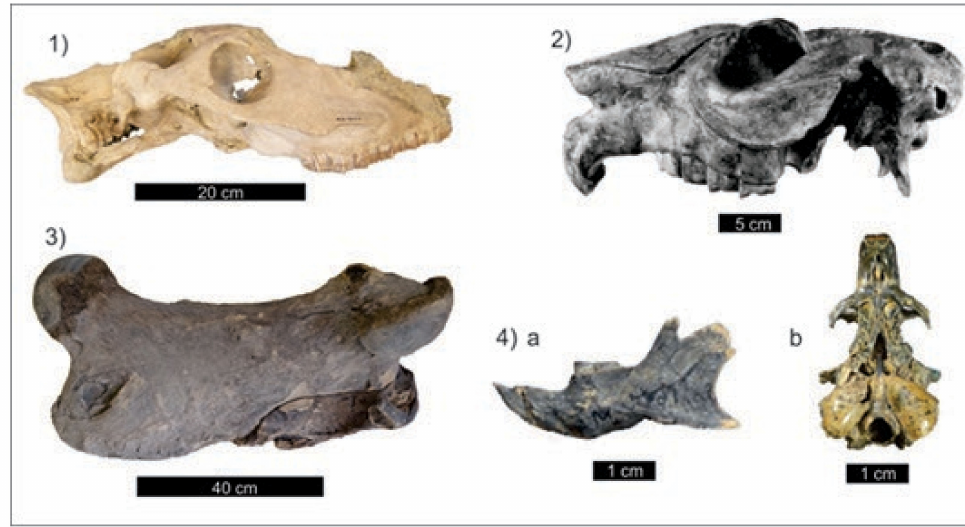
Figure 3. Four taxa from Argentinian Pampa that define the biozones. 1, Skull in lateral view of Equus neogeus ; 2, Skull in lateral view of Mesotherium cristatum ; 3, Femur of Megatherium americium ; 4(a,b), Skull in ventral view and mandible in lateral view of Ctenomys chapalmalensis